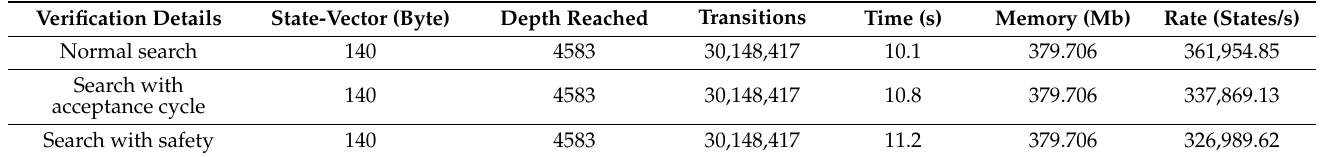
Table 2. SPIN verification result for interaction between different IdP.